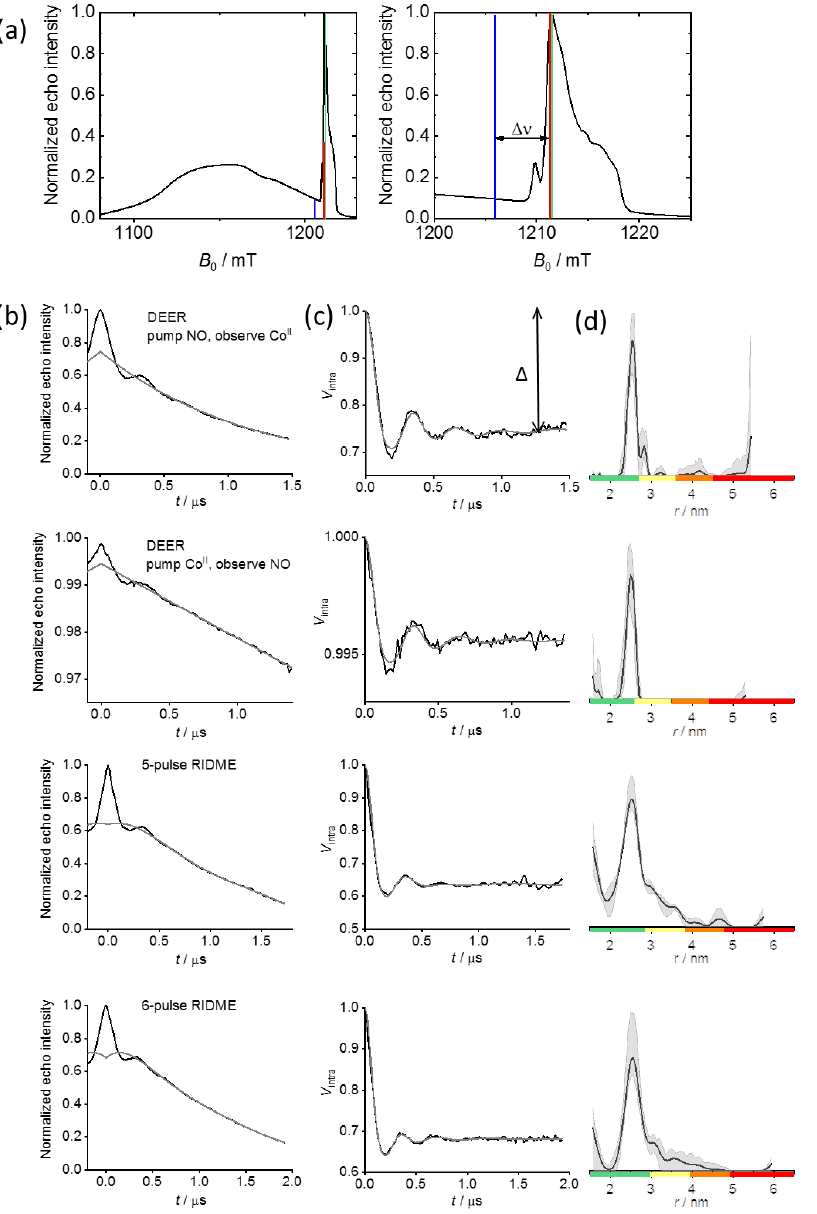
Figure 2. Q-band Co II -NO DEER and RIDME on 1 mM solutions of 1 at 15 K. ( a ) Echo-detected EPR spectrum of 1 at 15 K optimized for the Co II (left) and a zoom-in on the spectral region where pulses were applied (right). The red and blue lines denote the position of the pump and observe pulses of the DEER experiment (setup: observe Co II and pump NO) and the green line denotes the position where RIDME was performed; ( b ) primary PDS data with the gray line indicating the background decay, ( c ) background-corrected PDS data with the gray line indicating the fit and ( d ) distance distributions (black lines) with confidence intervals (gray shadowed areas) and reliability (colored bar below the distance distributions). The various experiments are indicated in the first row and the experimental parameters are given in Tables S2 and S3, Supplementary Materials. The ∆ is indicated in ( c ) top row. Number of scans from top to bottom 15, 44, 1 and